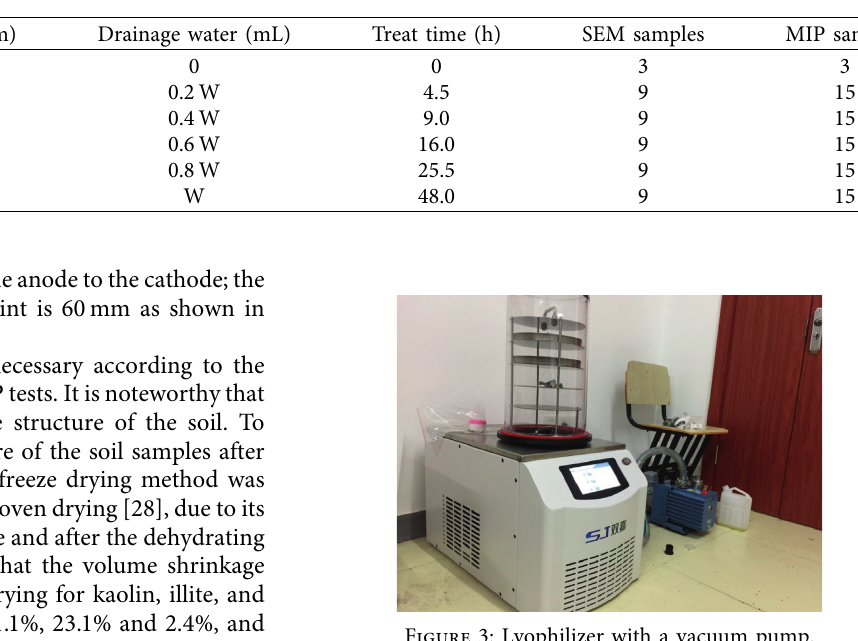
Figure 2: (a) Testing apparatus diagrams. (b) Sample locations. Table 2: Details of the EO tests.